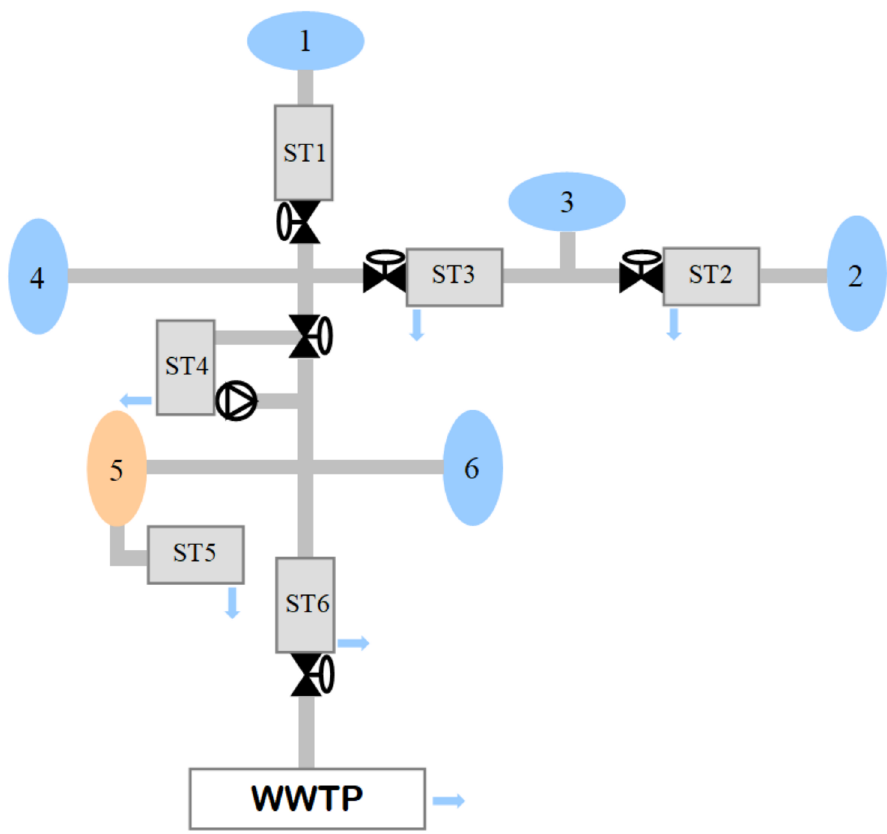
Figure 1. Catchment and sewer